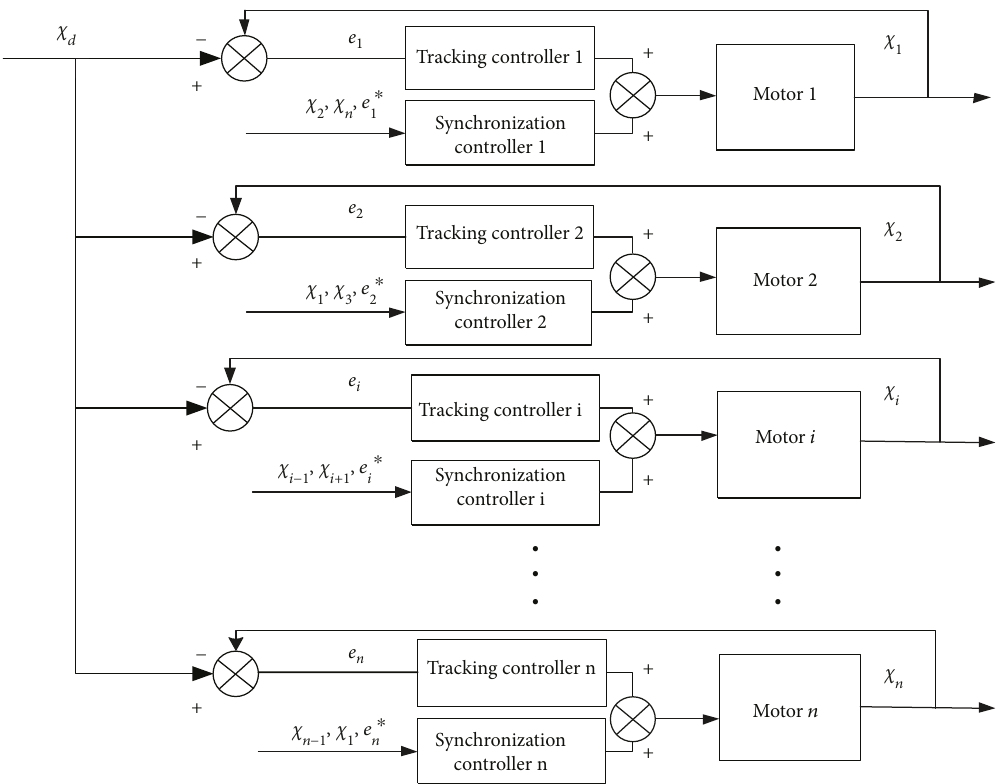
Figure 4: Schematic diagram of enhanced adjacent